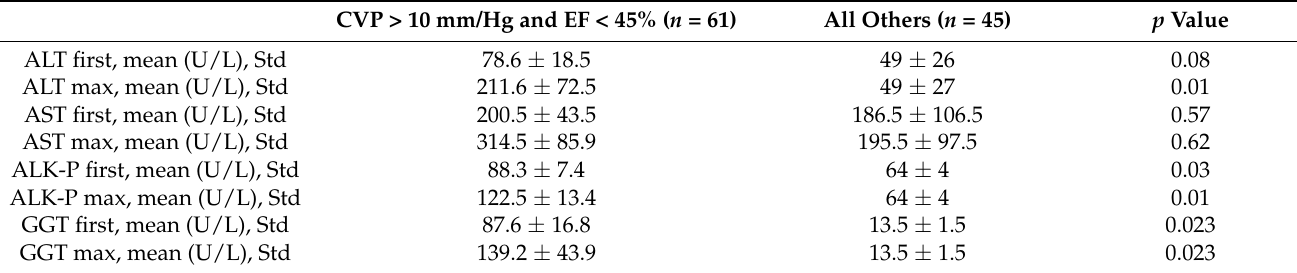
Figure 1. Median levels of baseline and peak liver enzymes in four groups. ( A ) AST first and maximal values, ( B ) ALT first and maximal values, ( C ) GGT first and maximal values and ( D ) ALP first and maximal value. Table 3. Propensity score matching of liver enzymes for the group of worst cardiac function vs.